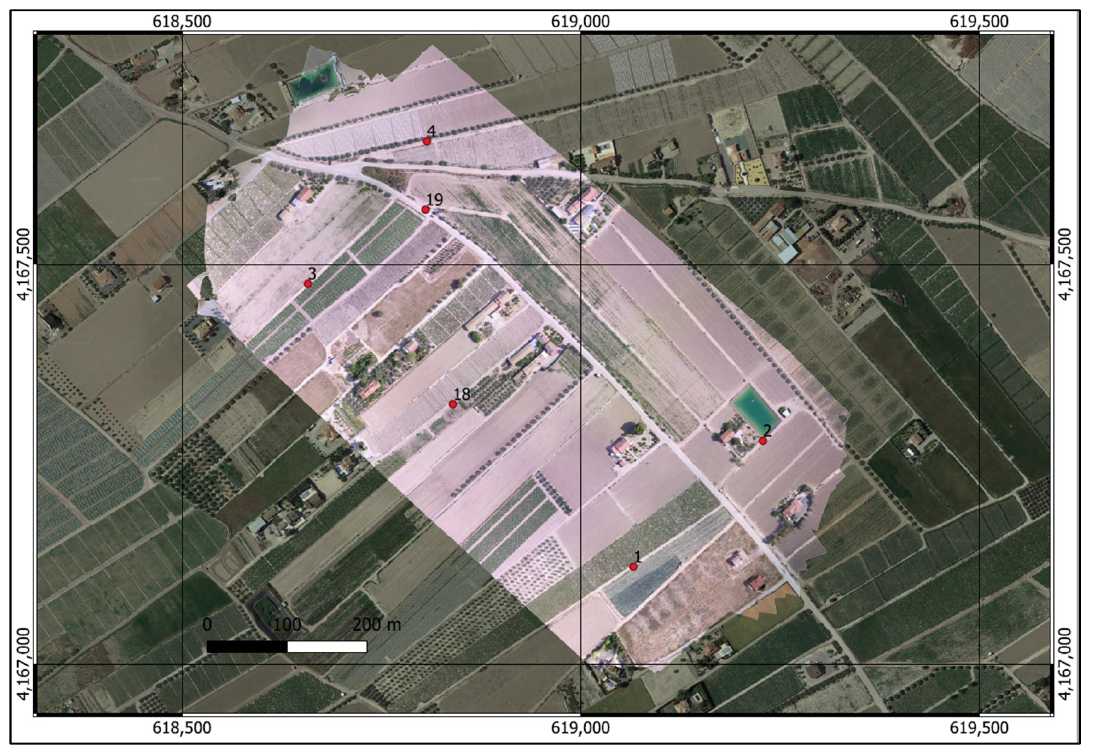
Figure 8. Orthophotograph of Block 1 created after the photogrammetric process; background image from Google Satellite orthophotograph. The GCPs are shown distributed at the four corners of Block 1 for the four scenarios (points 1, 2, 3, and 4); points 18 and 19 were left as ChPs.